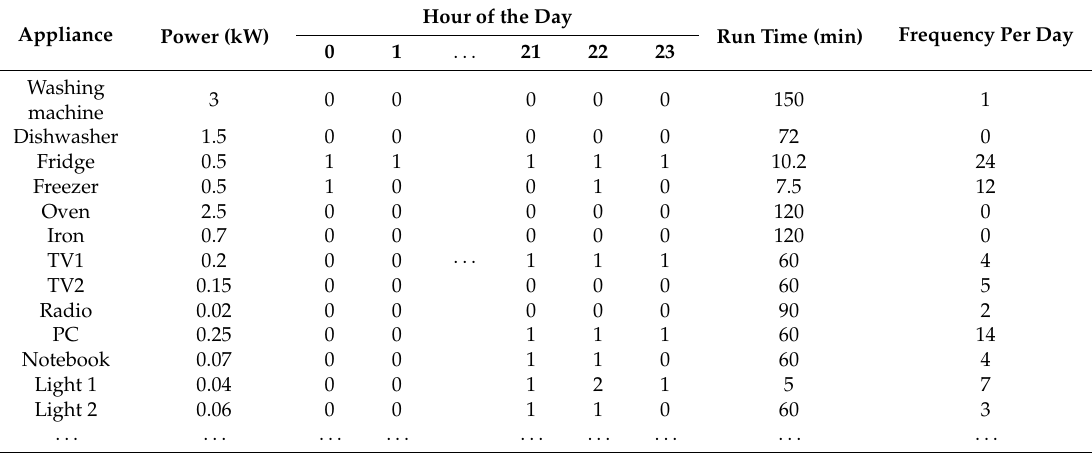
Table 1. The estimated energy consumption schedule of a typical small consumer (a summertime